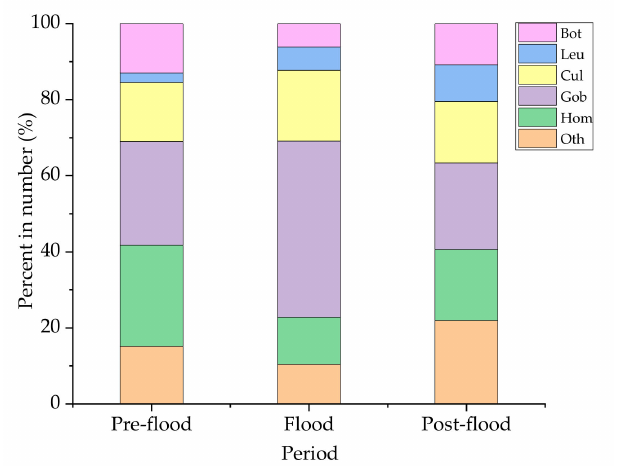
Figure 4. Percentages of eggs and larvae in dominant groups among samples collected from the Laibin section of Xijiang in the summer of 2017. Bot: Botiinae; Leu: Leuciscinae; Cul: Cultrinae; Gob: Gobiobotinae; Hom: Homalopteridae; Oth: Others.